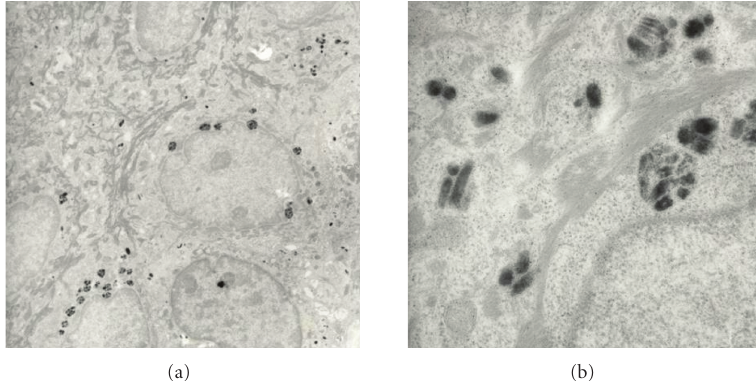
Figure 3: Electron microscopy of a ff ected skin . Left (8:300 × ): sparse melanosomes aggregated in small clusters and some solitary. Right detail (49:800 × ): Melanosomes mostly grade I-II, few grade III and less